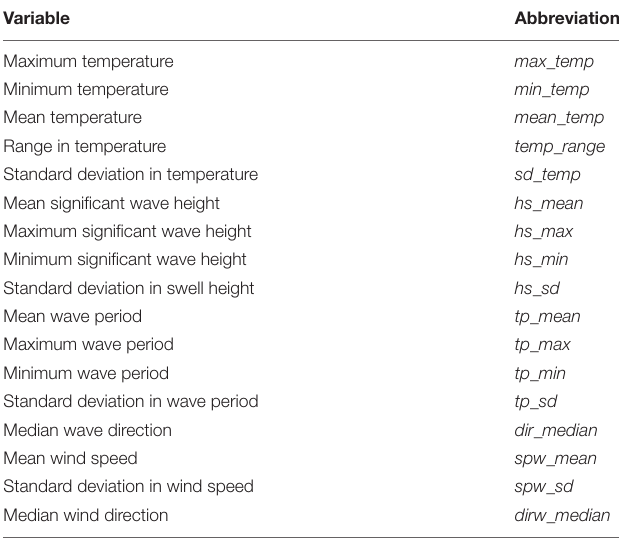
TABLE 2 | A list of measured environmental variables (temperature, waves and wind) and their associated abbreviations.